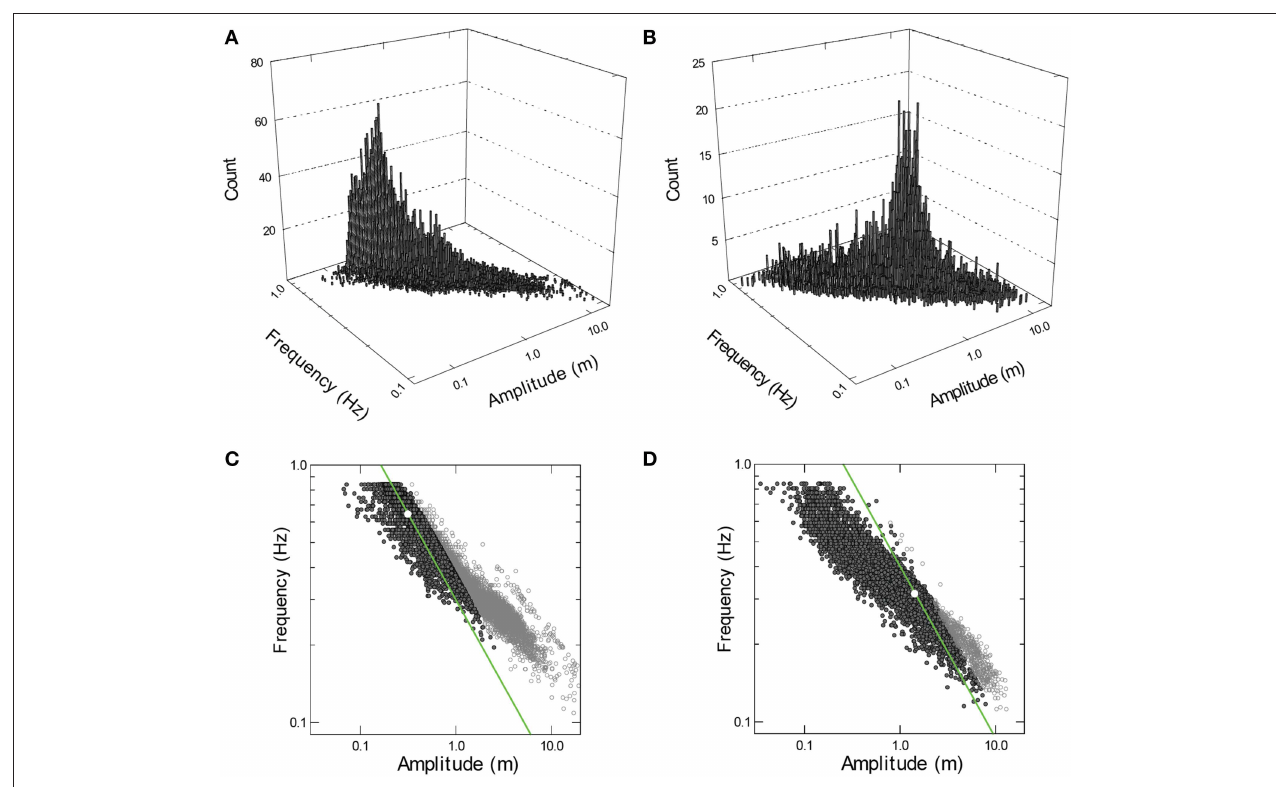
FIGURE 2 | (A,B) Frequency histograms for combinations of propulsive stroke frequency and amplitude used by the larger ( A,C ; n = 11 , 657 strokes) and smaller ( B,D ; n = 6481 ) whale shark. Data projected onto the horizontal planes (C,D) define a narrow band within which there is a sharply defined axis of locomotor gaits (see narrow ridges in A,B ). Modal combination of frequency and amplitude is identified by a white circle. Power (P) at the caudal fin was calculated as: P = m · p · A2 · f2 · (1 - cos(f · p)), where, m is the mass of water affected by the caudal fin (assumed constant for each shark and removed from the calculation), A is amplitude (in m), and f is stroke frequency (in tail beats per second). Combinations of frequency and amplitude producing power equivalent to the power at modal frequency and amplitude are identified by a green line. Symbols outlined in black identify data P ≤ 2 times modal